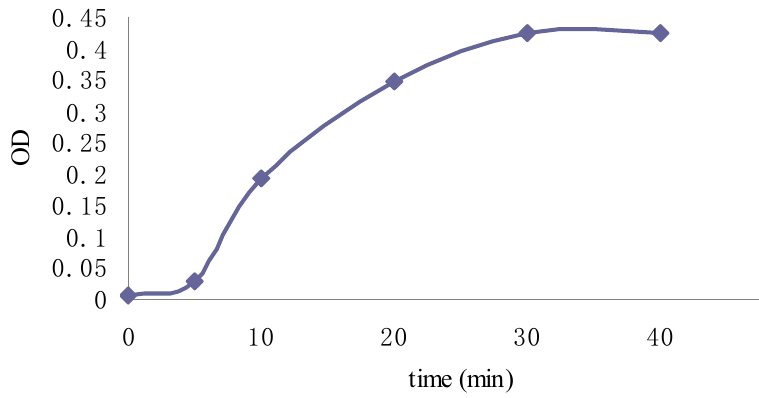
Figure 11. Hydroxyl radical-scavenging activity of Fuco stereoisomers and VE as measured by Fenton’s reagent. ( A ) (all- E )-Fuco; ( B ) 9' Z -Fuco; ( C ) 13 Z - and 13' Z -Fuco; ( D )